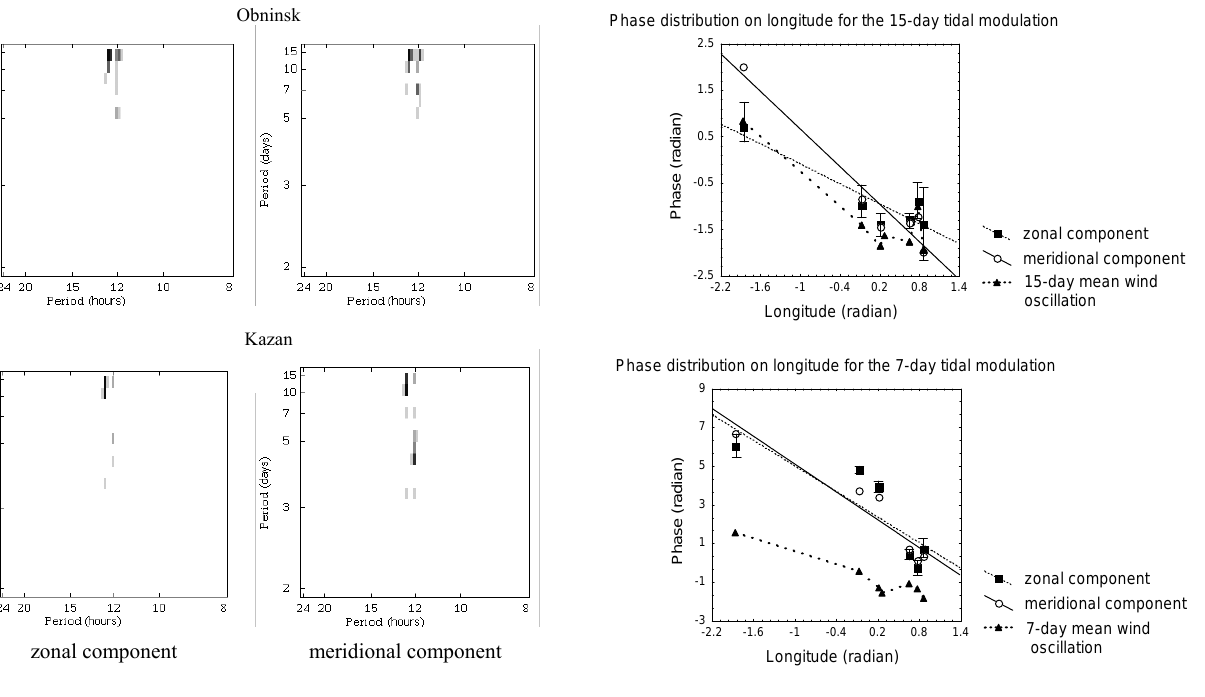
Fig. 5. As Fig. 4, but for the Eastern European sites.